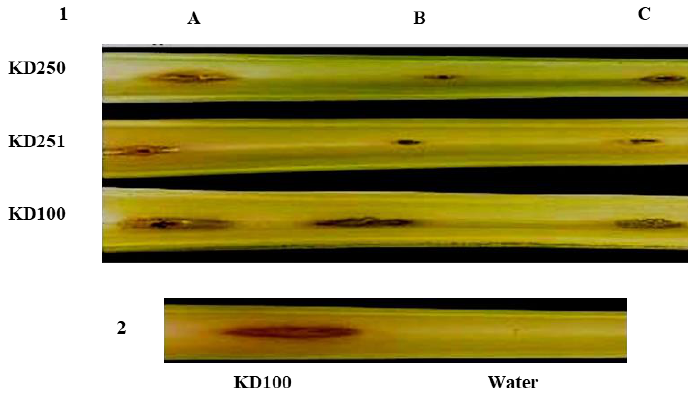
Figure 6. Celery petioles maceration by P. carotovorum strain KD100 and its wcaG mutants KD250 and KD251. Infection of KD250, KD251 was compared with parent KD100 and also with complemented mutants. (1) Column ( A ) indicates infection of KD250, KD251, and KD100 carrying extrachromosomal copies of wcaG in pCKD252; Column ( B ) infections of KD250, KD251, and KD100 carrying pLAFR5; Column ( C ) infections of KD250, KD251, and KD100. (2) Maceration caused by strain KD100 was compared with the negative control.